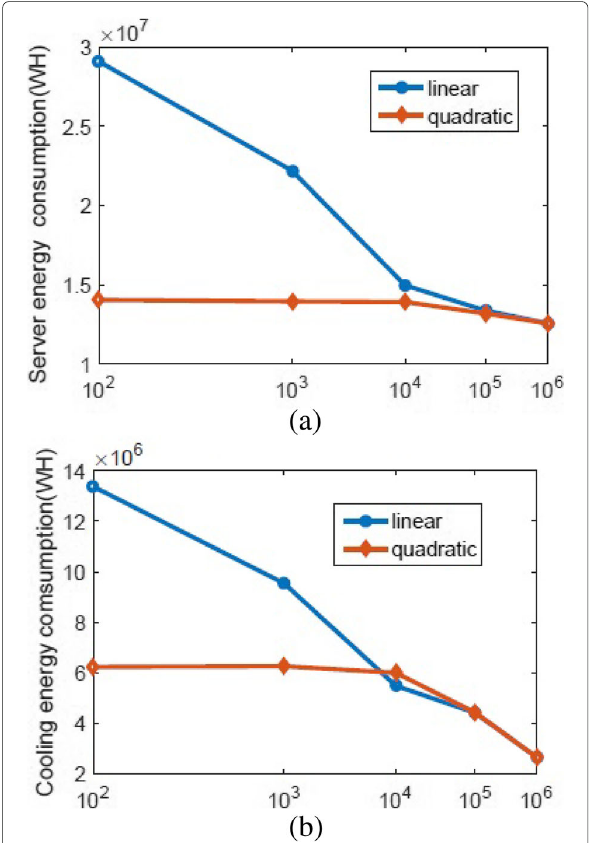
Fig. 8 Energy comparison for different components under linear and quadratic control. a Server energy, b Cooling energy